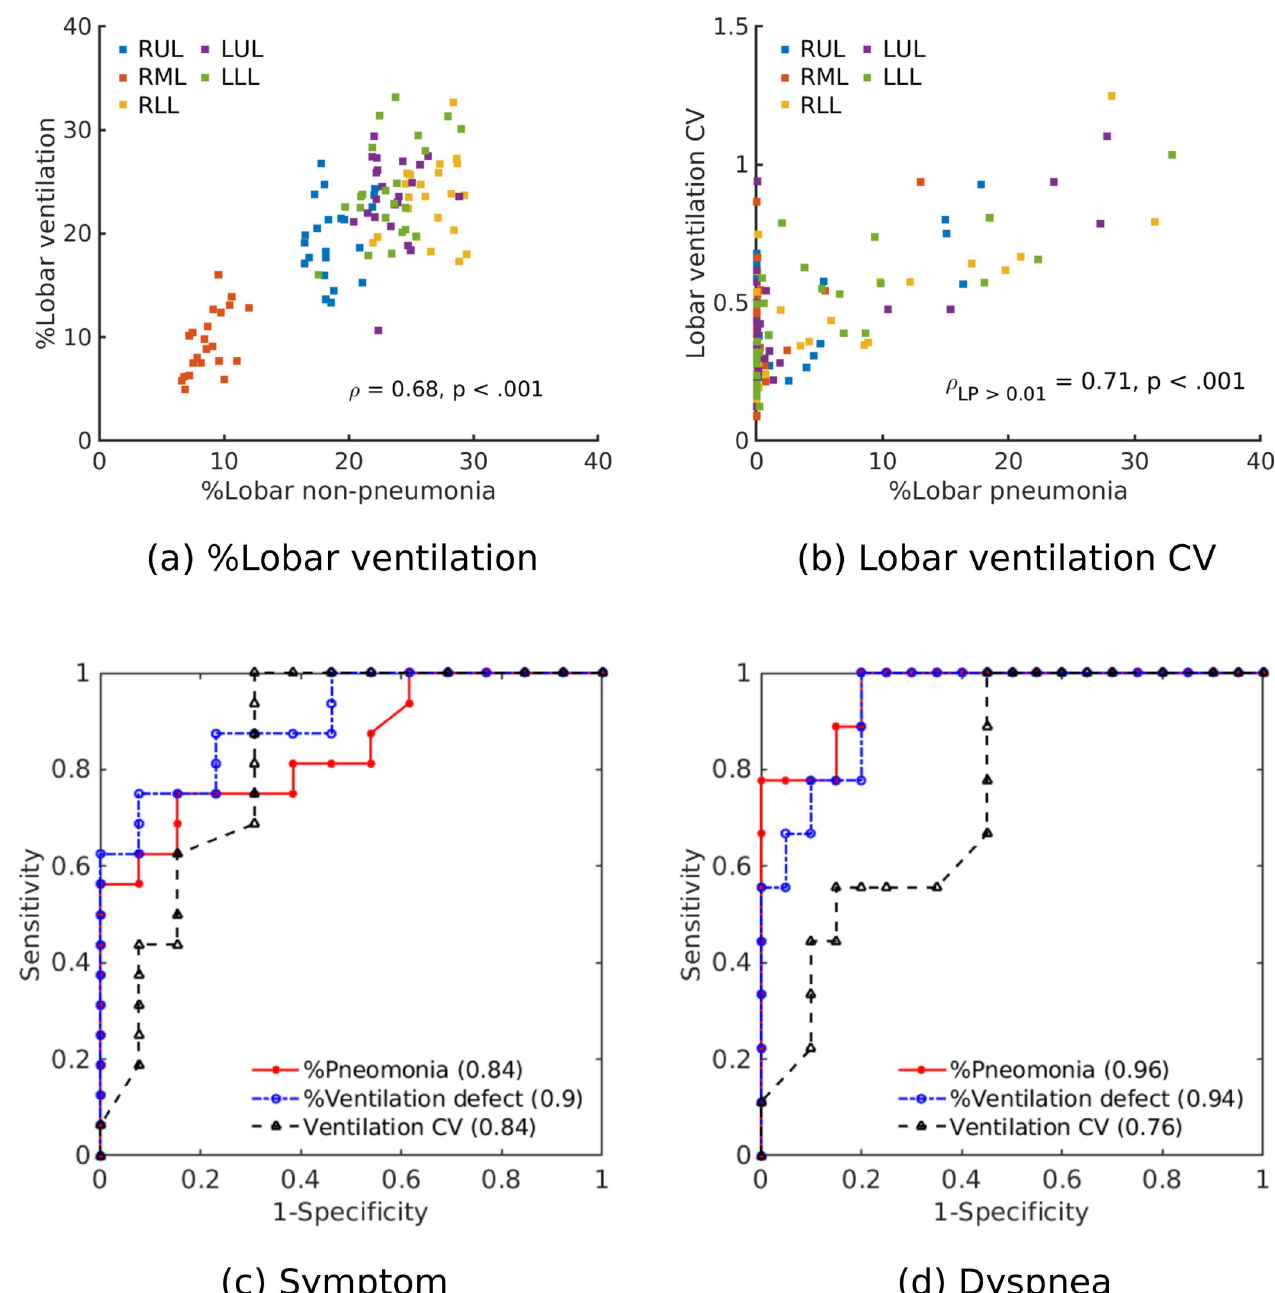
Fig 6. Relationship between (a) %lobar ventilation and %lobar non-pneumonia; (b) ventilation CV to %lobar non-pneumonia. Receiver operating characteristic (ROC) curves to classify (c) symptoms and (d) dyspnea. The area under the curves for %pneumonia, %ventilation defect and ventilation CV are shown in the